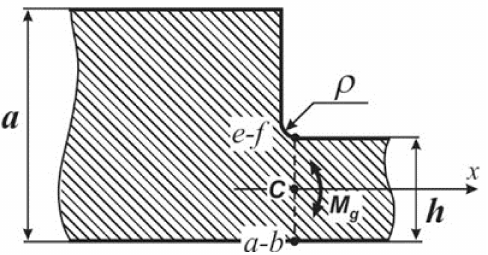
Figure 8. Simplified load scheme assumed for the lip restraint cross-section Symbols: M g , variable bending moment; h , lip height; a , pump body wall thickness; ρ , notch fillet radius; e–f , a–b , extreme fibers carrying the highest